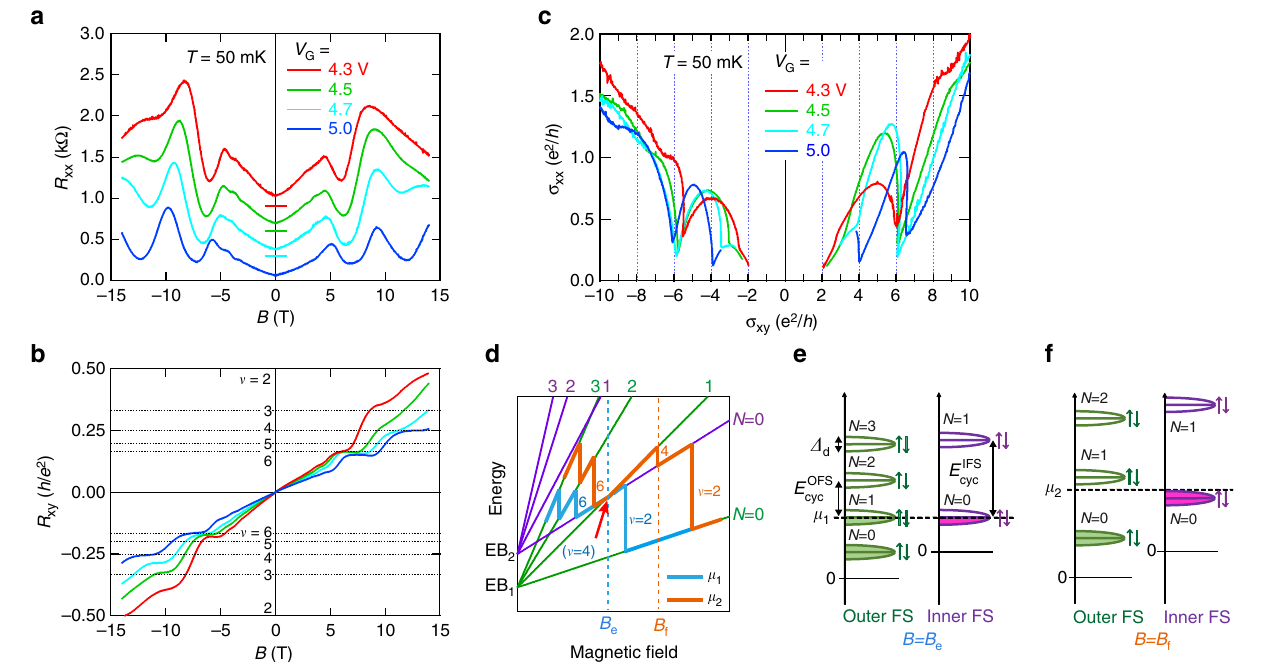
Figure 3 | Carrier density dependence of quantum transport in d -doped SrTiO 3 . ( a , b ) Longitudinal resistance R xx ( a ) and Hall resistance R xy ( b ) versus magnetic field B measured at 50mK with various V G ’s. For R xx , the traces are shifted vertically for clarity as denoted by horizontal bars. Horizontal dotted lines in b are the Landau level filling factors ( n ¼ 2 (cid:2) 6). ( c ) Parametric plots of ( s xy ( B ), s xx ( B )) for various gate voltages at 50mK. ( d ) A schematic of Landau levels as a function of magnetic field. Green and purple lines correspond to the Landau levels ( N ) of outer (EB 1 ) and inner (EB 2 ) subbands, respectively. All lines contain up and down spin states, assuming spin degeneracy due to the small g -factor. The thick blue and orange lines illustrates the chemical potentials ( m 1 and m 2 ) for low and high V G ’s. If the chemical potential (blue line m 1 ) is located at the crossing point of N ¼ 1 of the outer subband and N ¼ 0 of the inner subband (indicated by the arrow), then n ¼ 4 is expected to vanish. Shifting the chemical potential upward away from this crossing point (exemplified by the orange line ( m 2 )), n ¼ 4 can appear. ( e ) Landau level arrangement when n ¼ 4 disappears. D d is the Landau level broadening. E OFS and E IFS are the cyclotron energies of the outer and inner FSs, respectively. Note that each Landau level N is spin degenerate. ( f ) Landau level arrangement cyc when n ¼ 4 can be